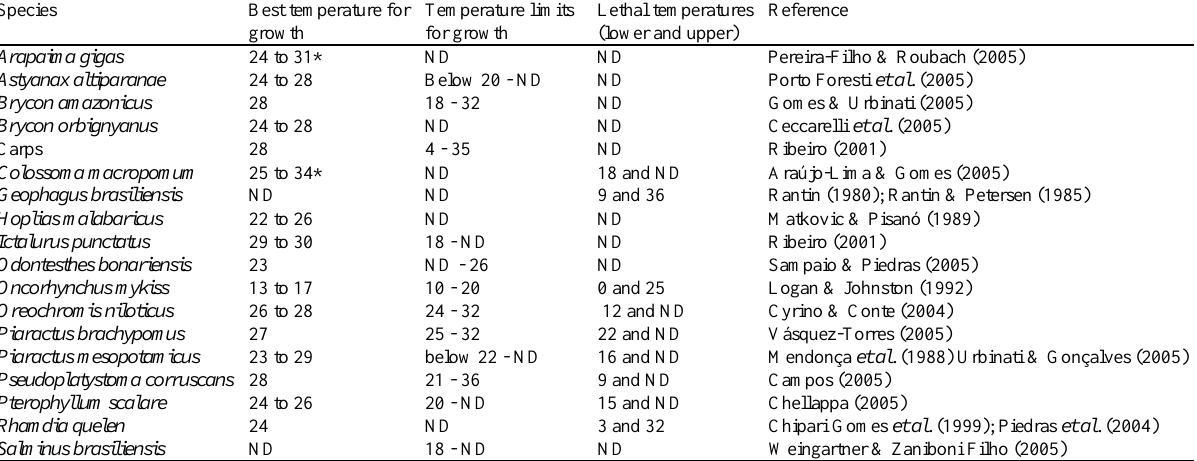
Table 1. Temperature ranges (ºC) for freshwater fishes raised in Brazil. * Water temperature from the natural habitat and proposed by the authors (growth experiments not performed). ND – Not determined.